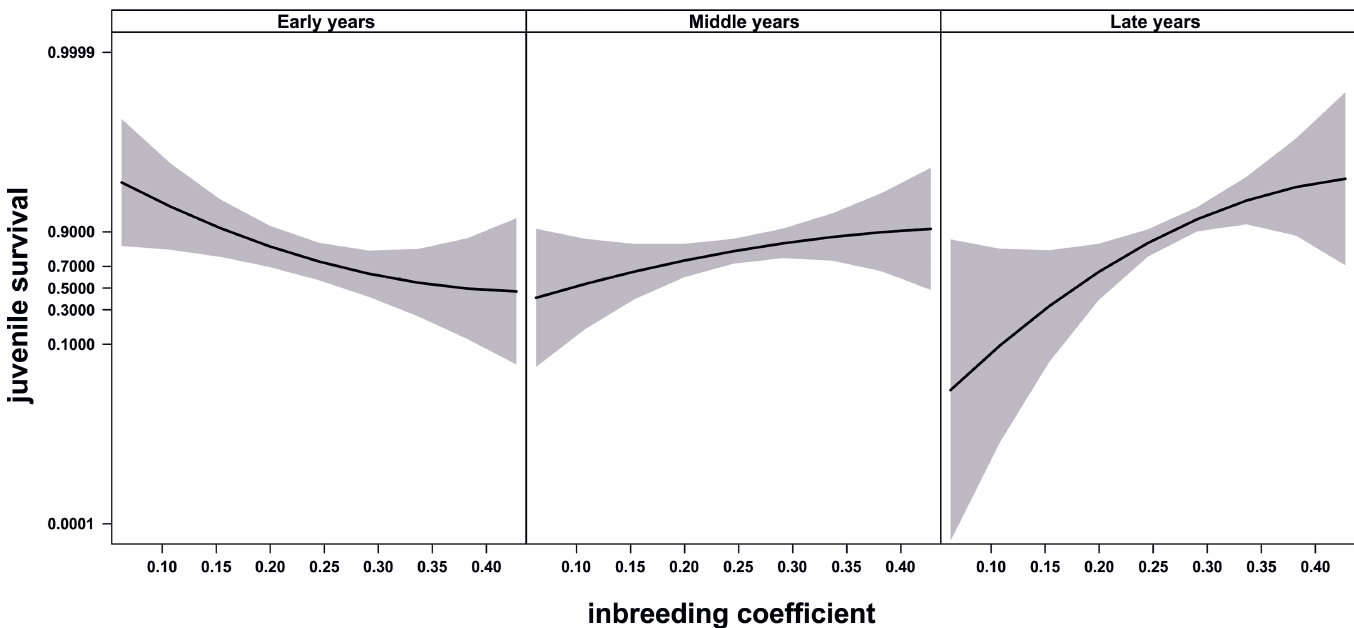
Fig 3. Evolution of juvenile survival through time. Relationship between inbreeding and juvenile survival through time. Juvenile survival is a dichotomous variable in which 0 indicates dead individuals and 1 indicates surviving individuals. Figure shows predicted values and 95% confidence bands. Time progresses from left to right, so the left graph shows the relationship between inbreeding and juvenile survival centred in year 1981, while the right graph shows this relationship centred in year 2006 when a major change in pairing management occurred. Graphs were produced with library “ effects ” [68], which uses the estimates of the effects from GLMMs to predict the values across the entire expand of the explanatory variables. Confidence bands are calculated from standard errors estimated at each of three levels of inbreeding (0.0625, 0.2451 and 0.4277) within each of the time